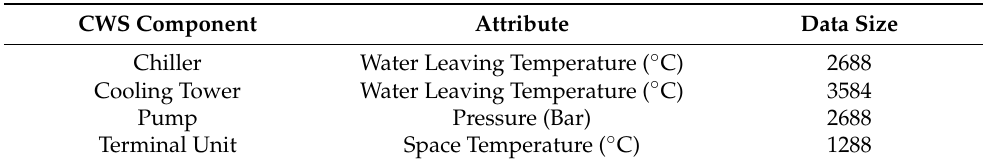
Table 7. Main Inputs of The Prediction